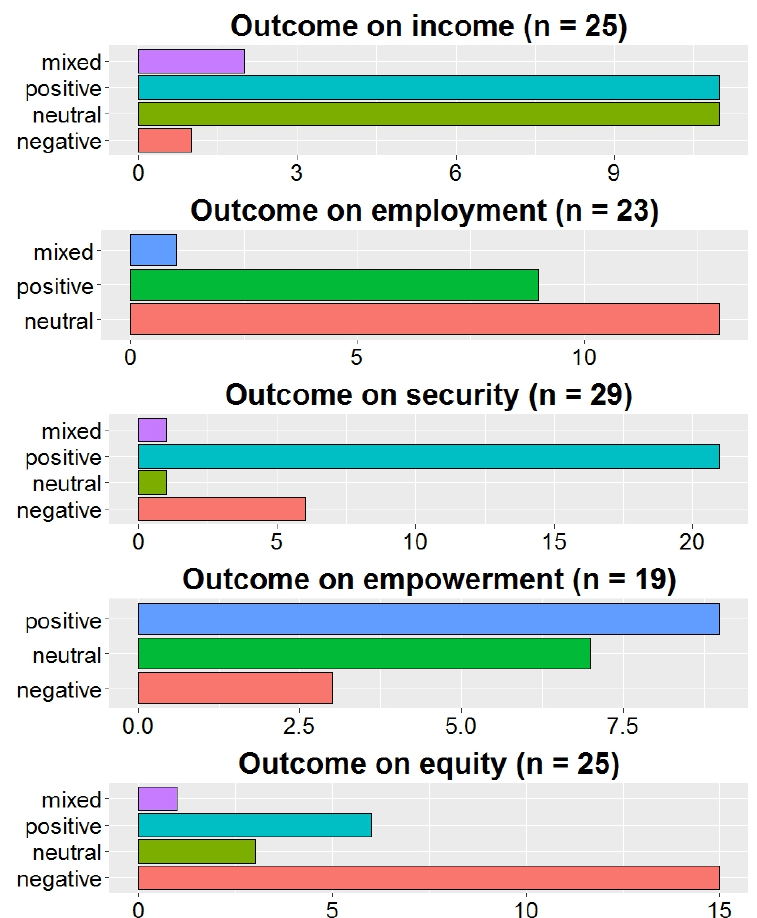
Figure 5. Frequency of the outcome identified for the five social criteria evaluated in this systematic review. The number of studies reporting on each criterion is indicated as the sample size ( n ).